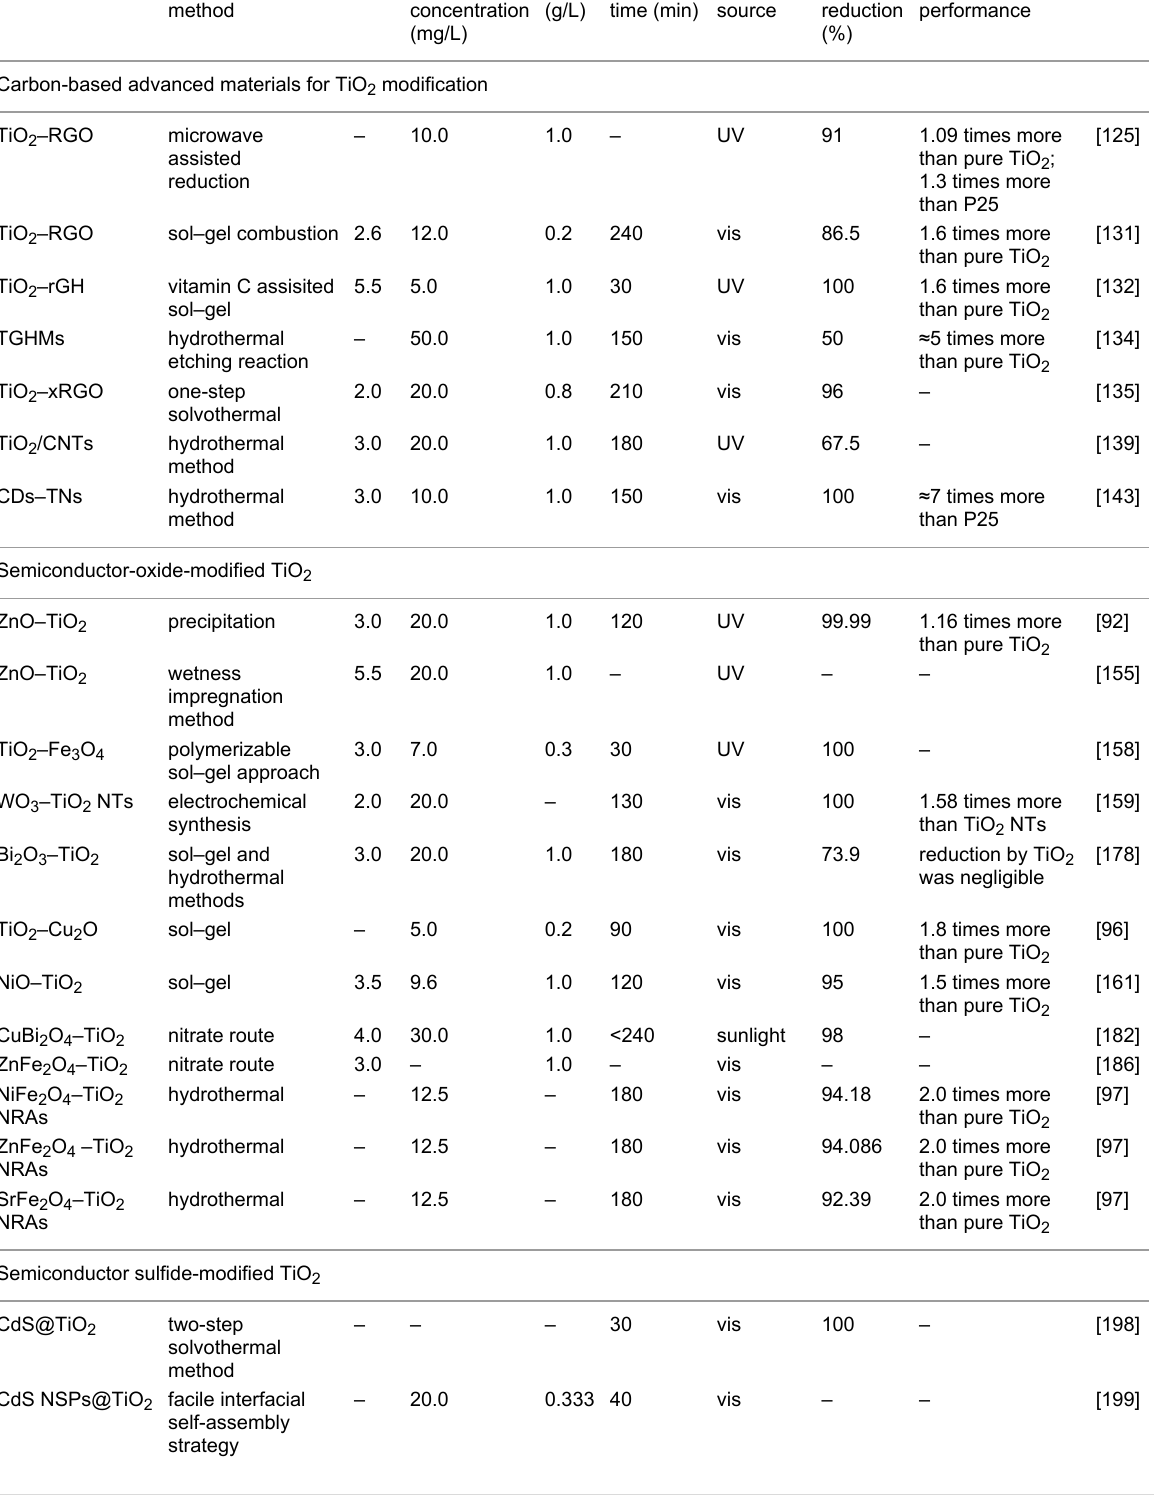
Table 1: Preparation methods of modified photocatalysts, experimental conditions for photocatalytic reduction of Cr(VI), source of illumination, per- centage of Cr(VI) reduction and comparison of the composite modified-photocatalyst performance with TiO 2 . Reduced graphene oxide (RGO), car- bon nanotubes (CNTs), carbon dots (CDs), nanorod arrays (NRAs), reduced graphene oxide hydrogel (rGH), TiO 2 hollow-core–shell microspheres (TGHMs), visible light spectrum (vis), ultraviolet light spectrum (UV).